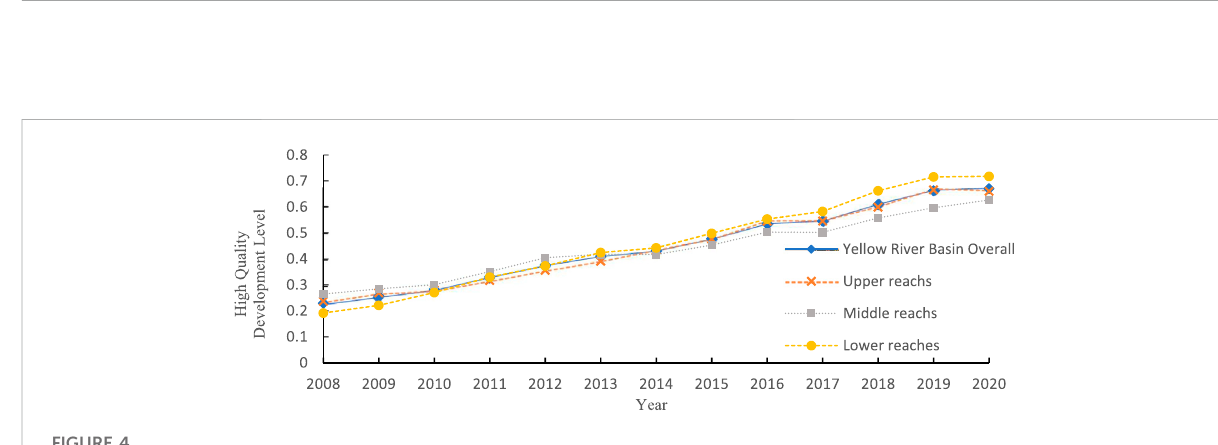
FIGURE 4 Temporal evolution of the level of HQD in the upper, middle, and lower reaches of the